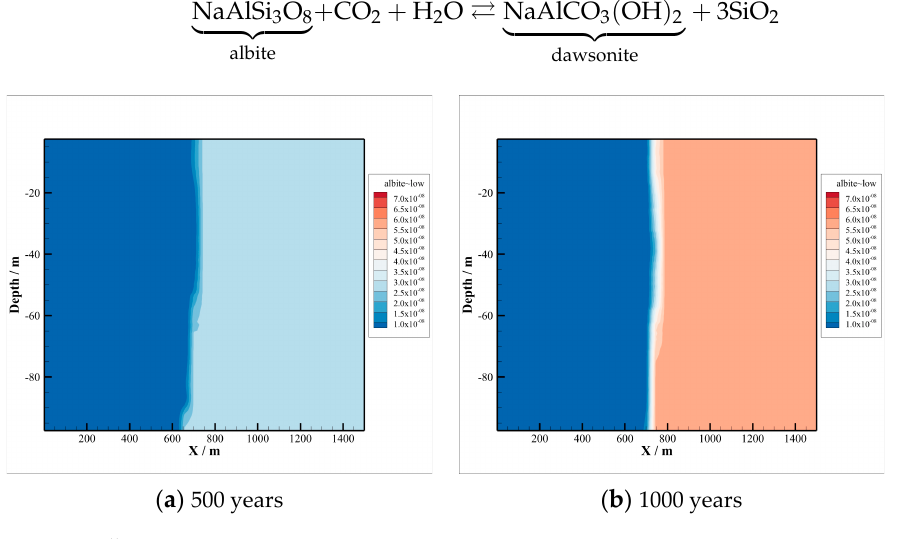
Figure 6. Albite precipitation.